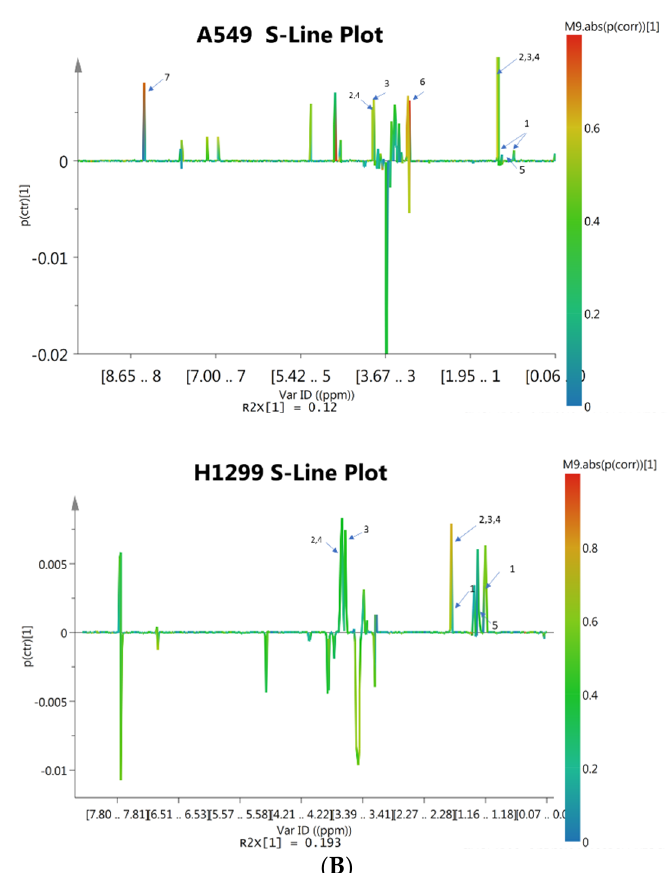
Figure 1. OPLS-DA analysis of metabolome of lung cancer cell lines after treating with/without δT for 72 h. ( A ) OPLS-DA Scores plot based on the cellular metabolic profiling of lung cancer cell lines, namely A549 (Top) and H1299 (Bottom); the 30 µM treatment (Yellow) and control (green) were generated using SIMCA+ software; the results indicated that cellular metabolic profiling of lung cancer cell lines was significantly changed after δT treatment for 72 h. ( B ) The S-Line plots of OPLS-DA analysis of A549 (top) and H1299 (Bottom) from treatment (30 µM) and control (0 µM) cells. The key metabolites that changed significantly are marked on the S-Line plot and include (1) leucine, (2) glutamine, (3) glutamate, (4) glutathione, (5) lactate, (6) taurine, and (7) formate.